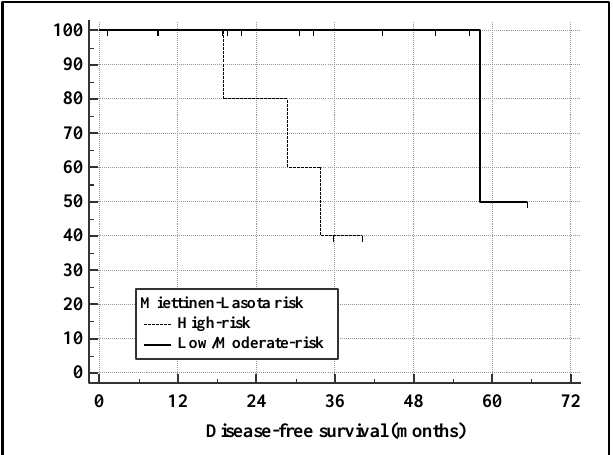
Figure 3: Kaplan-Meier disease-free survival curves according to the Armed Forces Institute